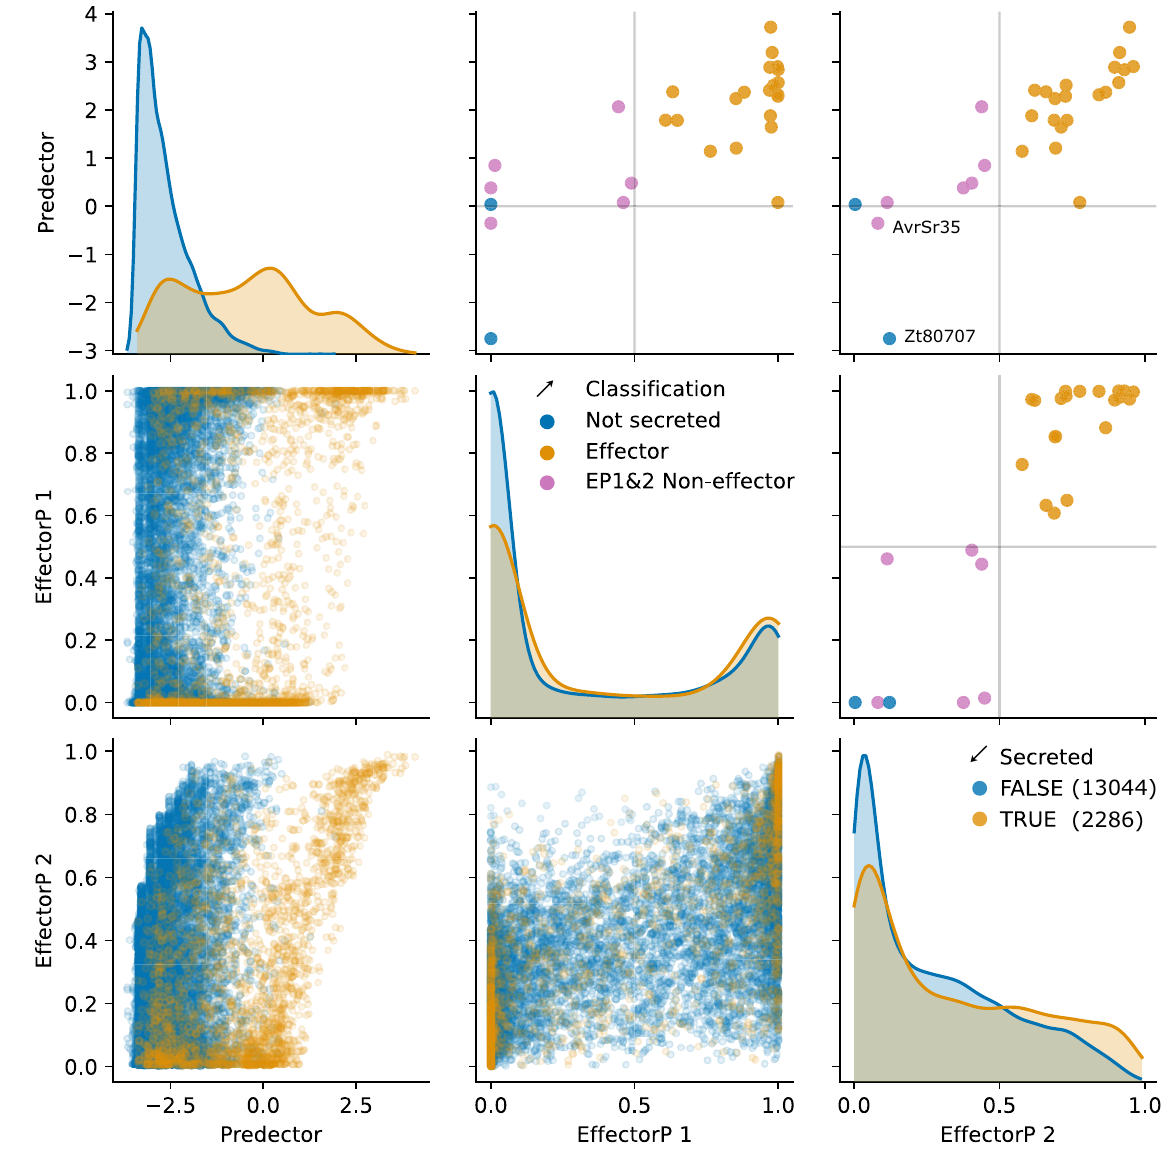
Figure 3. Comparing the scores of Predector with EffectorP versions 1 and 2 for proteins in the testing dataset. Scatter plots in the lower-left corner indicate comparisons of predictive scores between methods, with predicted secreted proteins (any signal peptide and fewer than two TM domains predicted) indicated in yellow, and non- secreted proteins indicated in blue. Density plots along the diagonal indicate distributions of the full test dataset versus predictive scores for each method (indicated along the x-axis), also coloured by secretion prediction as before (Note: there are far more non-secreted than secreted proteins in the dataset). Scatter plots in the top- right corner indicate score comparisons between methods for confirmed effectors, coloured by whether they have been predicted as secreted (criteria as above), or additionally predicted by EffectorP versions 1 or 2. Two proteins that are misclassified by a Predector score > 0 are labelled in the top-right